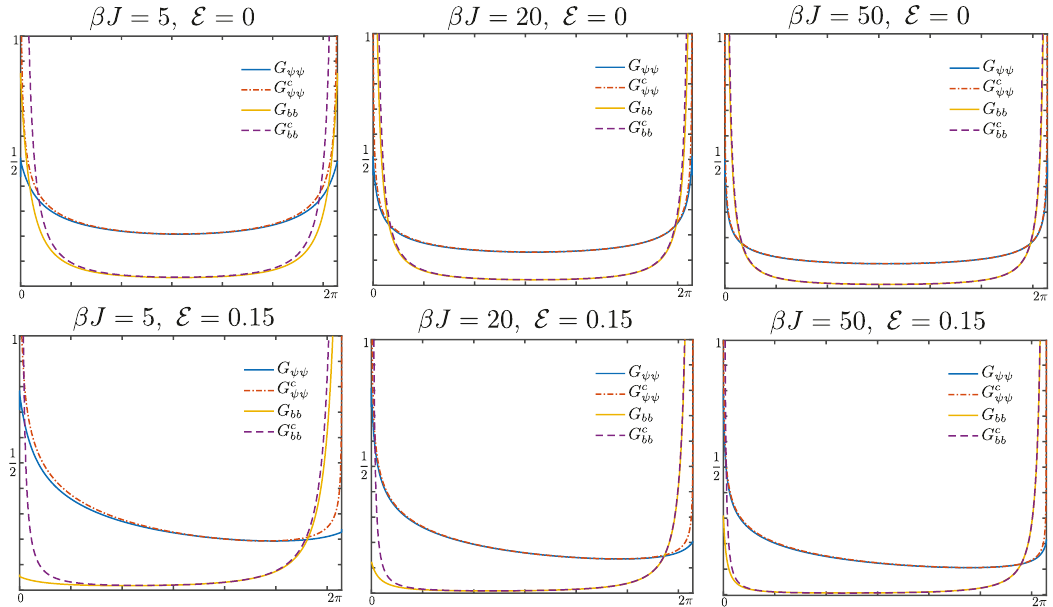
Figure 3 . Numerical solutions to large N Dyson Schwinger equations, where from left to right βJ = 5 , 20 , 50 and up to down E = 0 , 0 . 15 . We plot against dimensionless quantity 2 πτ plot the best fit conformal solutions G c τ ∼ O (1 /J )